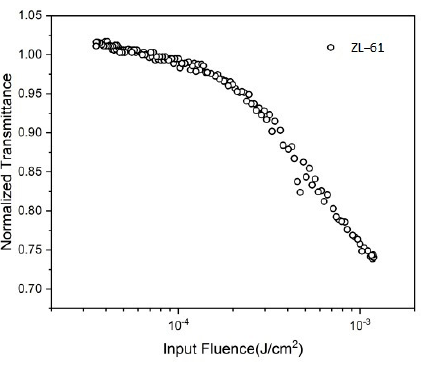
Figure 4. Femtosecond OL of ZL-61 under 800 nm. The dots represent experimental data.